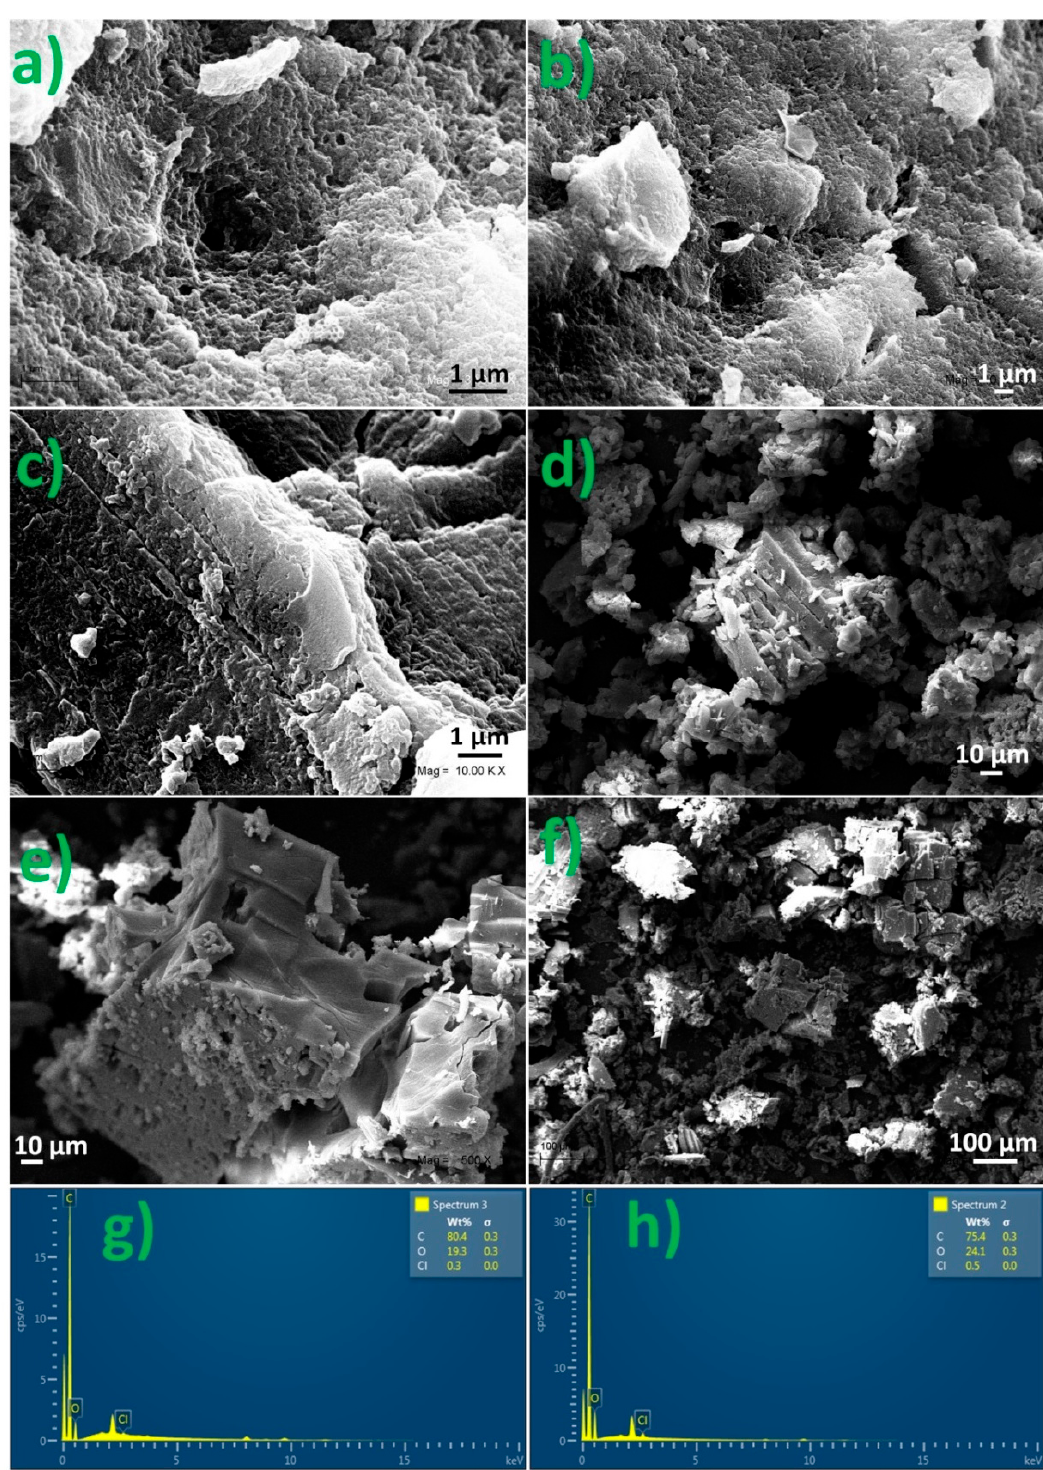
Figure 4. SEM image of nanosponges (NS) ( a , b ), NS–2,3,4,6-tetrachlorophenol (TCF) ( c , d ), and NS–4-chlorophenoxyacetic acid (4-CPA) ( e , f ), and energy dispersive X-ray spectroscopy (EDS) analysis of the NS–pesticide complex ( g , h ).